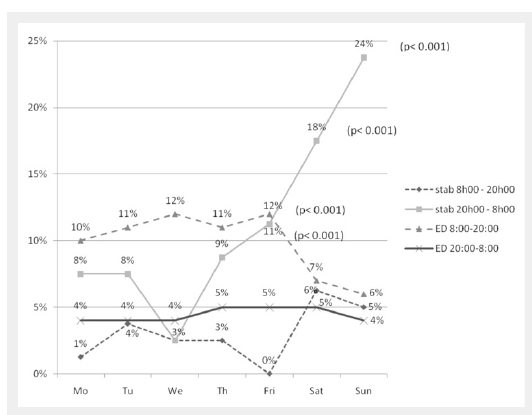
Chronologic distribution of the surgical ED admissions: Penetrating trauma (stab) is over-represented at night on Friday, Saturday and Sunday when compared to the other surgical casualties (ED) ( p <0.001).